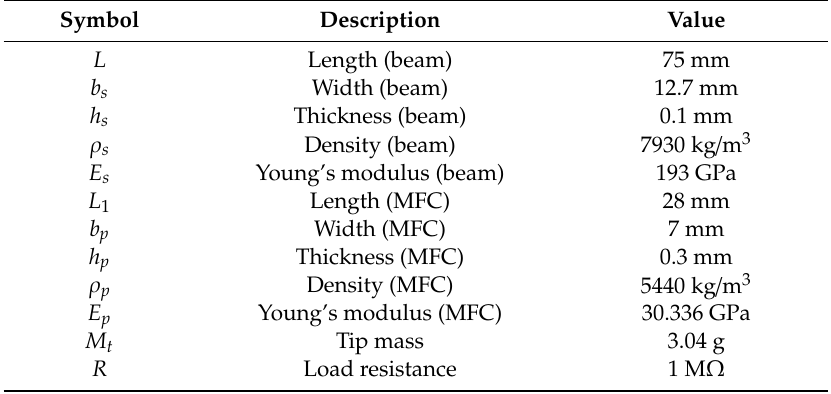
Table 1. Parameters of the PEH in the outward configuration.